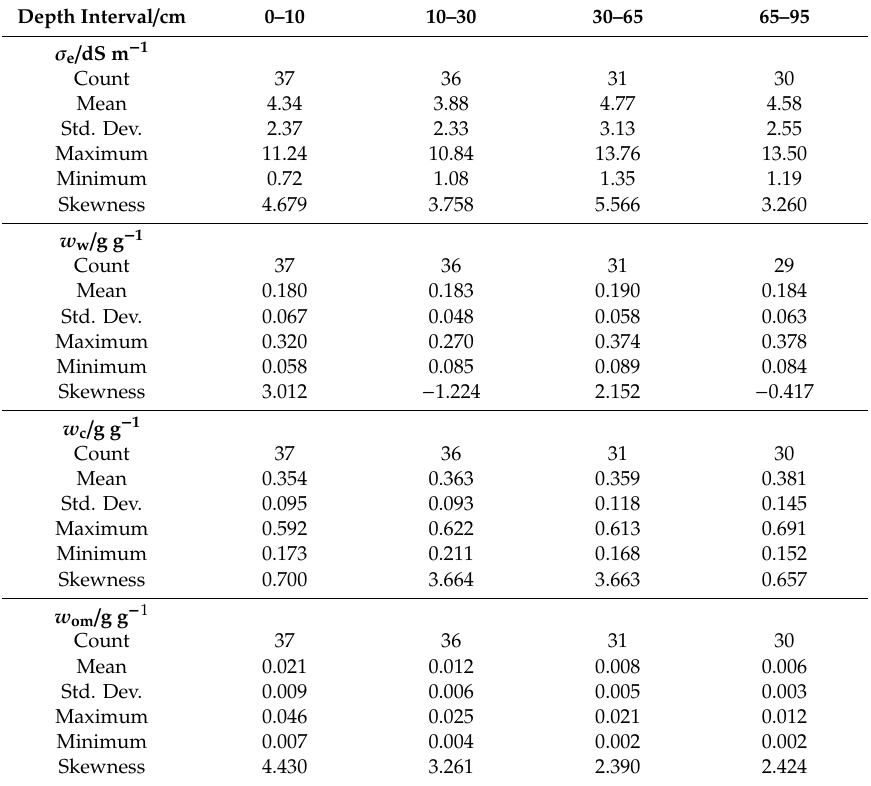
Table 2. Statistical summary of the data on saturation extract electrical conductivity at 25 ◦ C ( σ e ) and field water ( w w ), clay ( w c ), and organic matter ( w om ) mass fractions in the different sampled depth intervals.